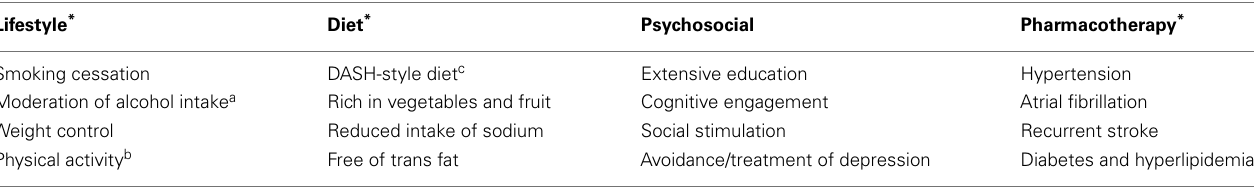
Table 1 | Interventions to reduce dementia